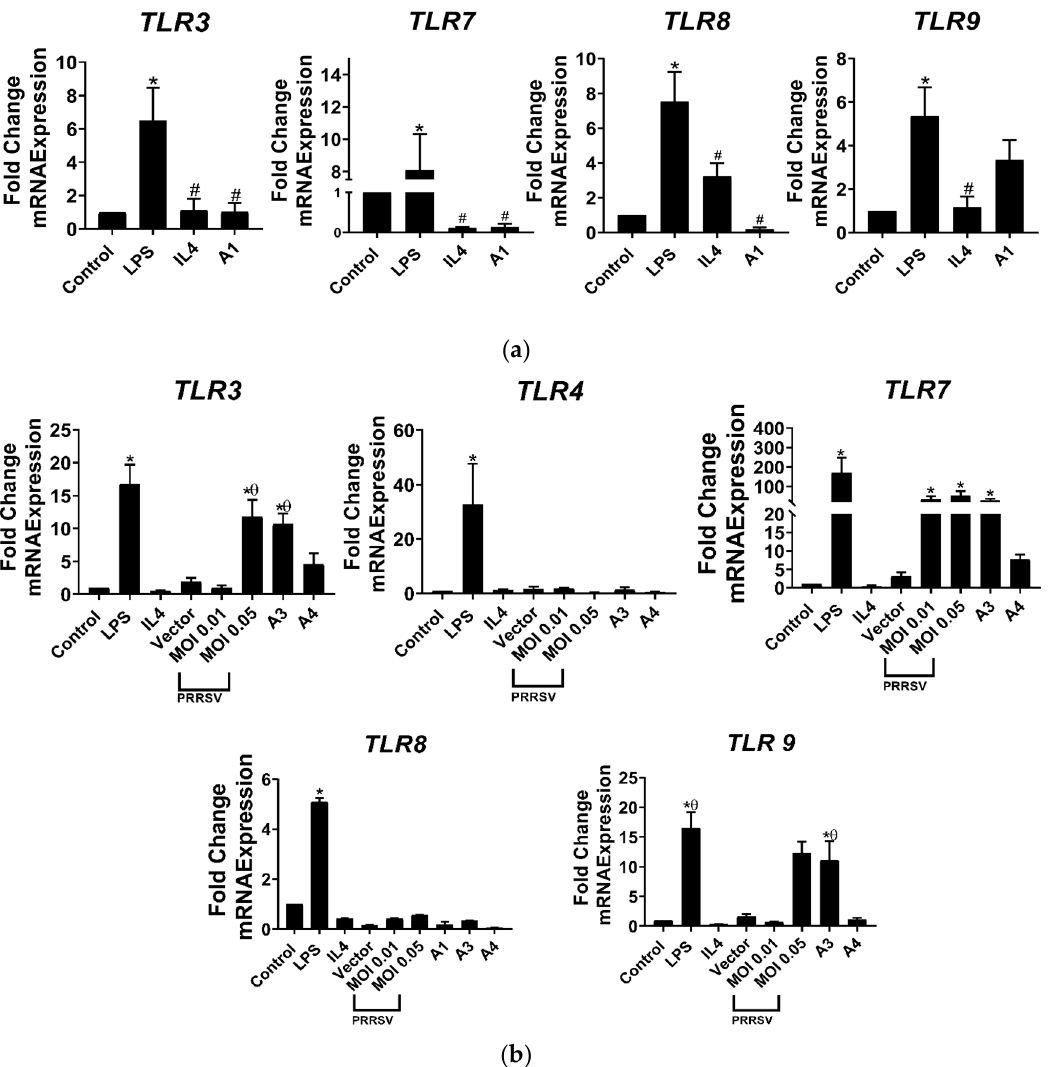
Figure 3. A3 induced the activation of TLR s, in parallel to PRRSV infection. ( a ) Data showed that A1 did not induce the activation of TLR s in PAMs. ( b ) A3 increased the expression of TLR3 , 7 , and 9 in PAMs, but not TLR4 and 8 . Untreated PAMs were used as control. * p < 0.05 compared to control group, # p < 0.05 compared to LPS group, θ p < 0.05 compared to 0.01 MOI. Data presented as means ± SEM, calculated from 4 pigs.